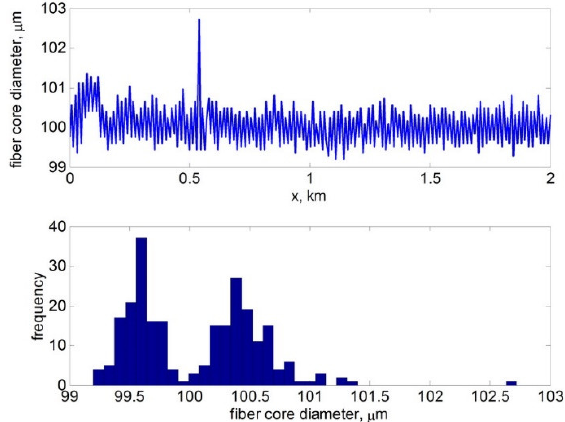
( b ) Figure 7. Spectral DMD (λ) curves over the “O”-band: ( a ) the reference MMF and the LDMDF samples; ( b ) the λ = 1310 nm wavelength region. 3.2. Simulation of 10GBase-LX Fiber Optic System Optical Pulse Propagation In the first step, we simulated a 10GBase-LX fiber optic system optical pulse propagation over a 100 μm core MMF with a total length of 2 km, and described the above refractive index profile presented in Figure 2, which corresponds to the measured real commercially available sample of the LOMF ISO/IEC 11801 OM2+/OM3 Cat. (MMF 50/125) profile [34], which was scaled up to a 100 μm core region. According to the previous paragraph results, this MMF provides the DMD with about 1800 ps/km at an operating wavelength of the 10GBase-LX system—λ = 1310 nm. Fiber irregularity is considered as the core diameter variations that are assigned by the array, taken from reports of commercially available MMF 50/125 outer diameter measurements performed